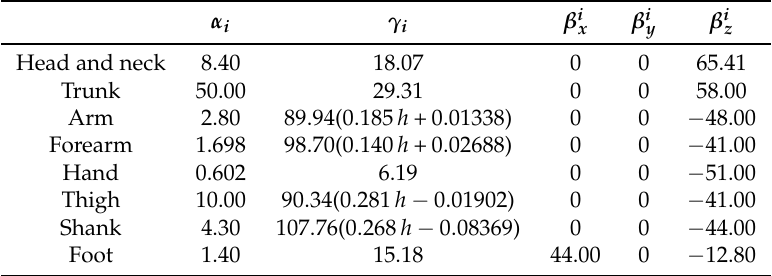
Table A3. Reynolds-NASA model parameters for each body segment (mass, length, and center of